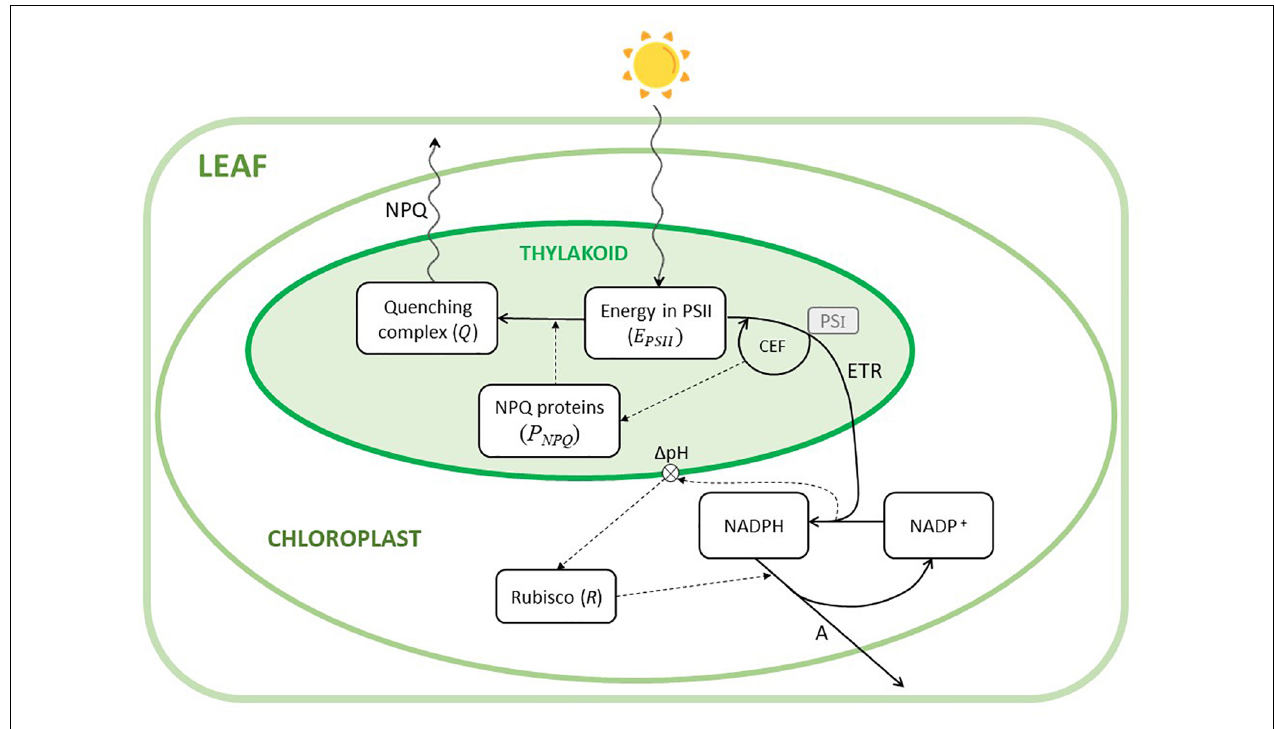
FIGURE 1 | Conceptual diagram of the model. The model describes the phenomena occurring in a chloroplast. The six state variables (i.e., E PSII , Q , P NPQ , NADPH , NADP , R ) are depicted by the white boxes. Continuous lines are fluxes, dashed lines describe influences, and wavy lines indicate either incident light or heat fluxes (NPQ). CEF is the cyclic electron flow transporting back electrons from photosystem I (PSI, not explicitly included in the model, represented in the small gray box) into the linear electron transport (ETR), whose energy is exploited to generate ATP (not represented) and influencing thylakoid pH and, therefore, the activation of the NPQ-related proteins ( P NPQ ). The transmembrane (cid:49) pH is influenced by the ratio NADPH/NADP + , which activates Rubisco. Rubisco is then responsible for the assimilation of CO 2